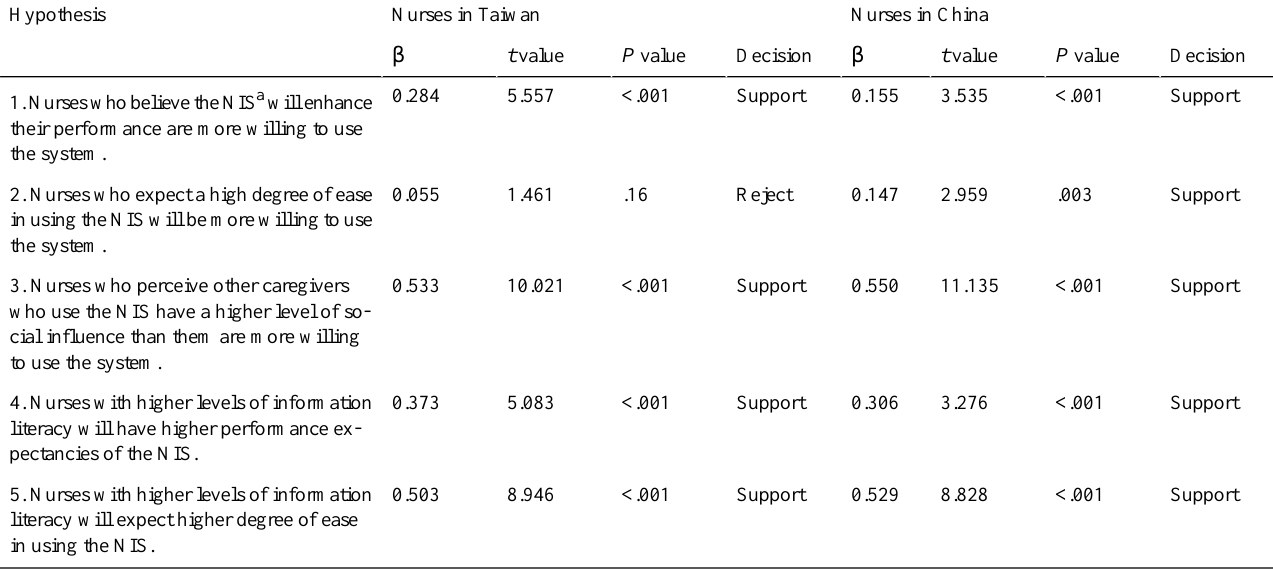
Table 3. Comparison of hypotheses test results.